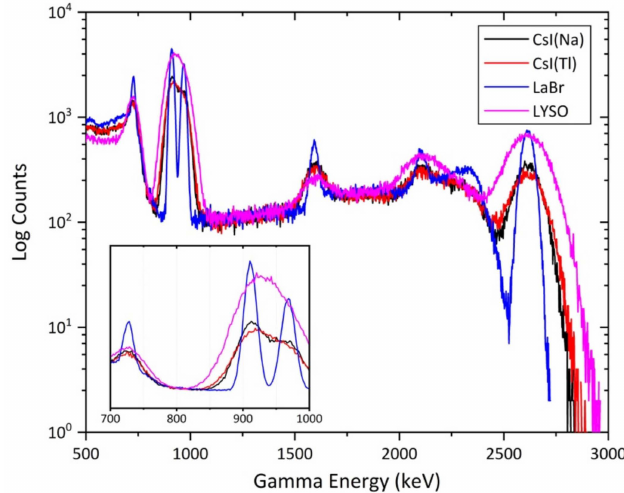
Figure 5. Comparison of the gamma-ray spectra obtained from various detector materials of identical volume when exposed to a 232 Th point